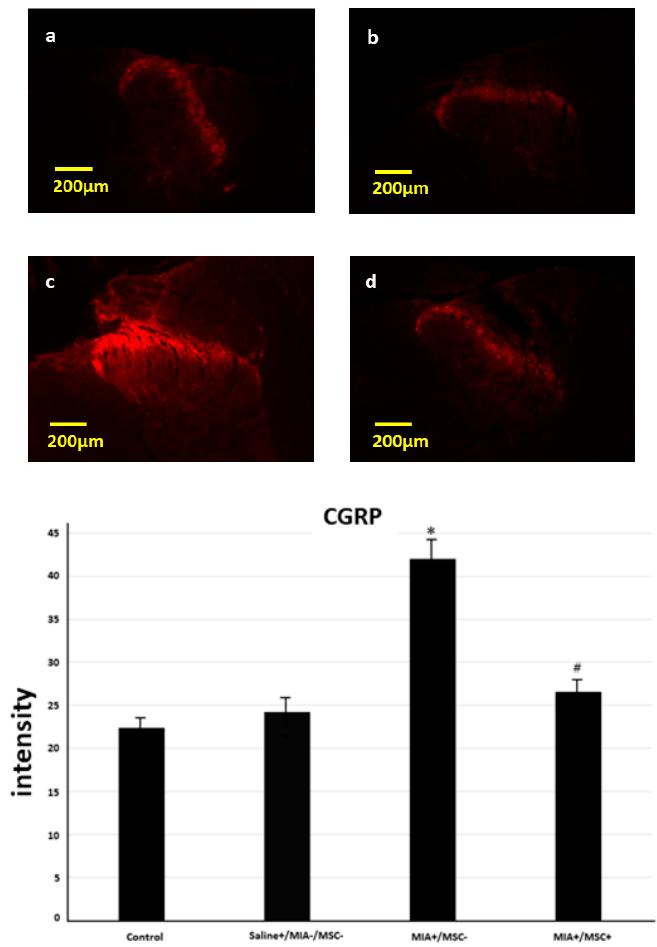
Figure 1. Calcitonin Gene Related Peptide (CGRP) expression in C5 spinal dorsal horn. ( a ) control group, ( b ) Saline group: CGRP is expressed in the posterior horn, ( c ) monoiodoacetate (MIA)+/mesenchymal stem cell (MSC) − group: CGRP is intensely expressed, ( d ) MIA+/MSC − group: CGRP